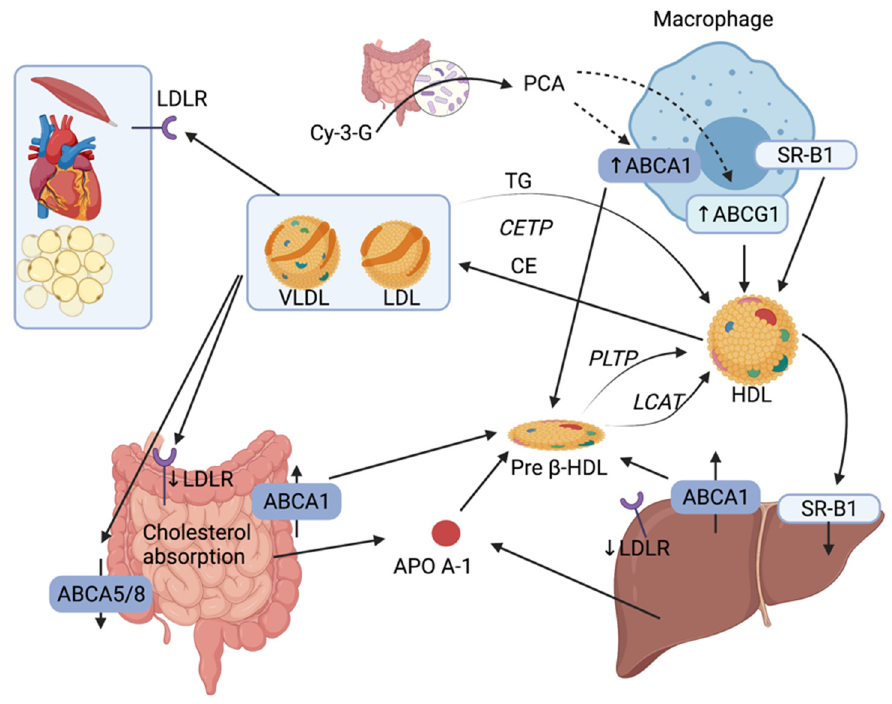
Figure 3. Reverse cholesterol transport pathways between intestine, liver and macrophage. RCT begins in the liver and the intestine with the synthesis of ApoA-1. ApoA-1 associates with phos- pholipids and free cholesterol through an interaction with ABCA1 located on various cell types (enterocytes, hepatocytes and macrophages). Gut microbiota modulates the RCT by increasing the level of ABCA1 and ABCG1 via the transformation of Cy-3-G into PCA. LDLR: LDL receptor;